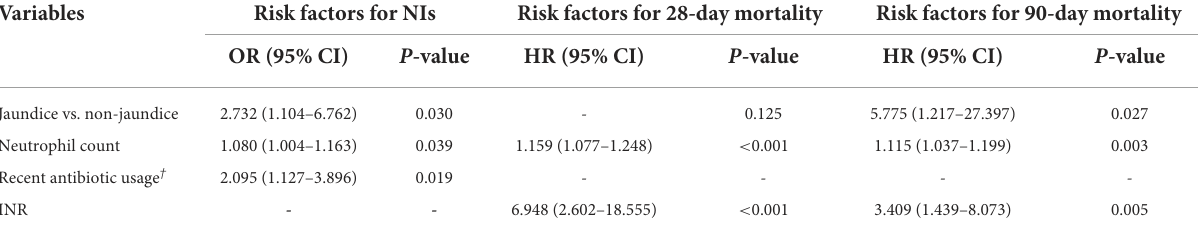
TABLE 4 Multivariate analysis of the risk factors for the development of NIs in patients with cirrhosis and AD and short-term outcome in cirrhotic patients with AD and NIs.